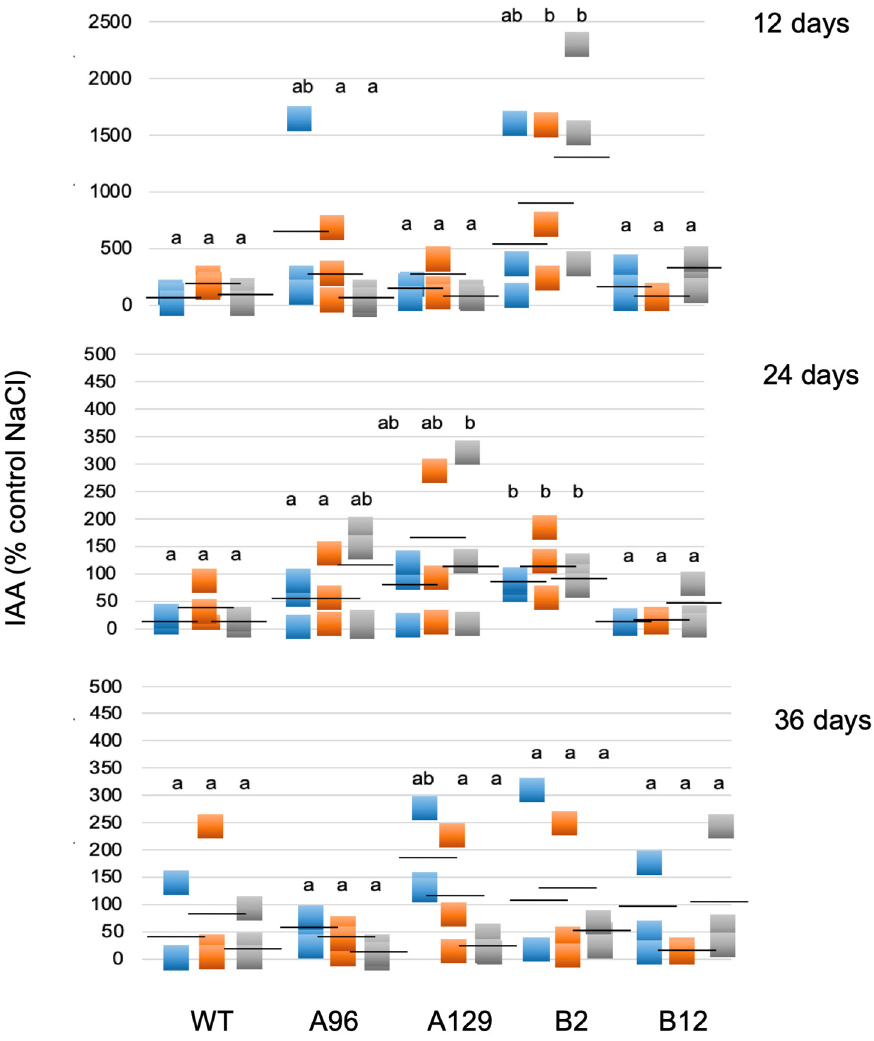
Figure 5. Free IAA levels given as % on control medium (0 mM NaCl). Blue = 50 mM NaCl; orange = 100 mM NaCl; grey = 250 mM NaCl. The IAA was determined at three different time points for three replicates. Different letters indicate significant differences to the control without NaCl at p < 0.05. Each square represents an individual data point and the black dash represents the mean value.